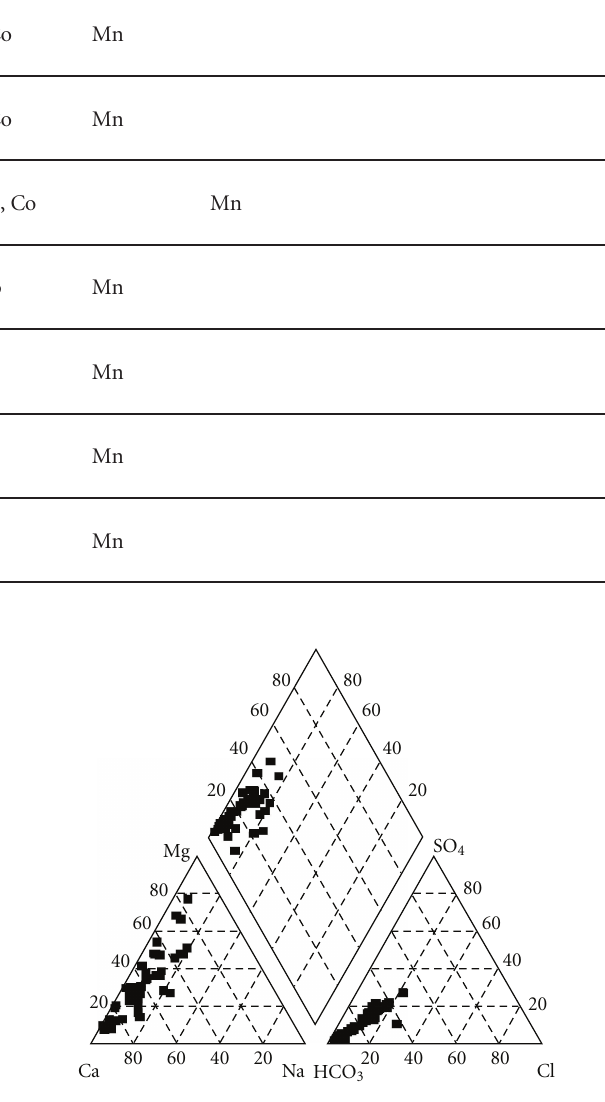
Figure 7: Piper diagrams relating to the samples of water from research